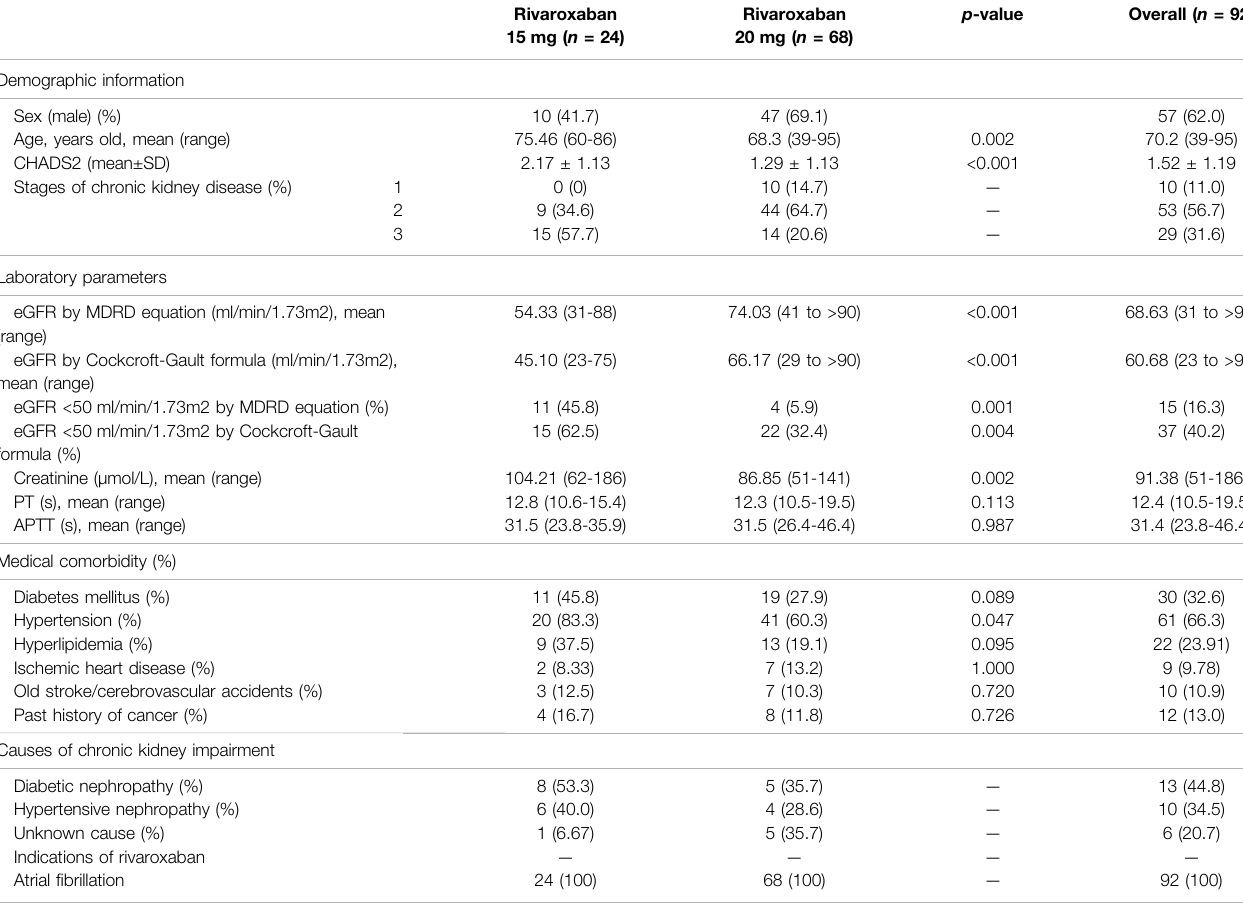
TABLE 1 | Baseline characteristics of patients receiving rivaroxaban 15 and 20 mg